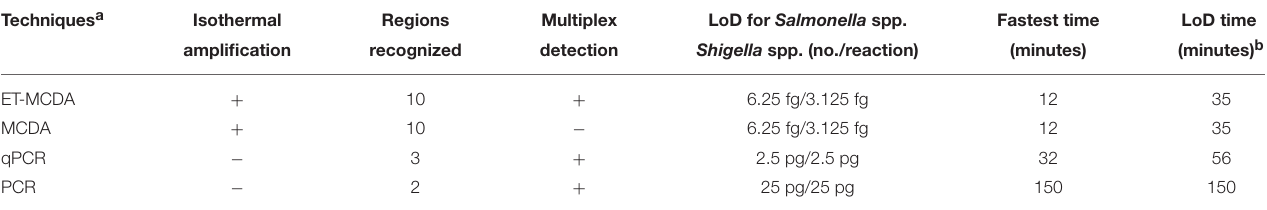
Techniques a Isothermal Regions Multiplex LoD for Salmonella spp. Fastest time LoD time amplification recognized detection Shigella spp. (no./reaction) (minutes) (minutes)